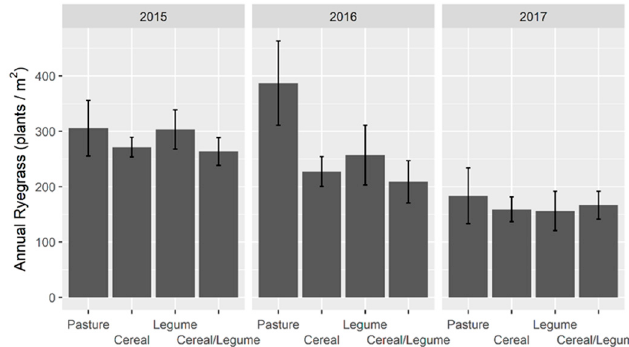
Figure 1. Annual ryegrass seedling density (plants/m 2 ) in winter forage crops grown in 2015–2017 at Wagga Wagga, NSW. Data displayed as the mean ± 2 × standard error (length of line in each direction). Barley grass seedlings were evaluated in the 2016 (7.5 plants/m 2 ) and 2017 (11.6 plants/m 2 ) forage crops (Figure 2). Barley grass seedling density was higher ( p < 0.05) for legume than cereal/legume and higher ( p < 0.05) for pasture than both cereal and cereal/legume in 2016. Additionally, barley grass density was higher ( p < 0.05) for legume and pasture than cereal and cereal/legume crops in 2017, and higher ( p < 0.05) for legume forages in 2017 compared to